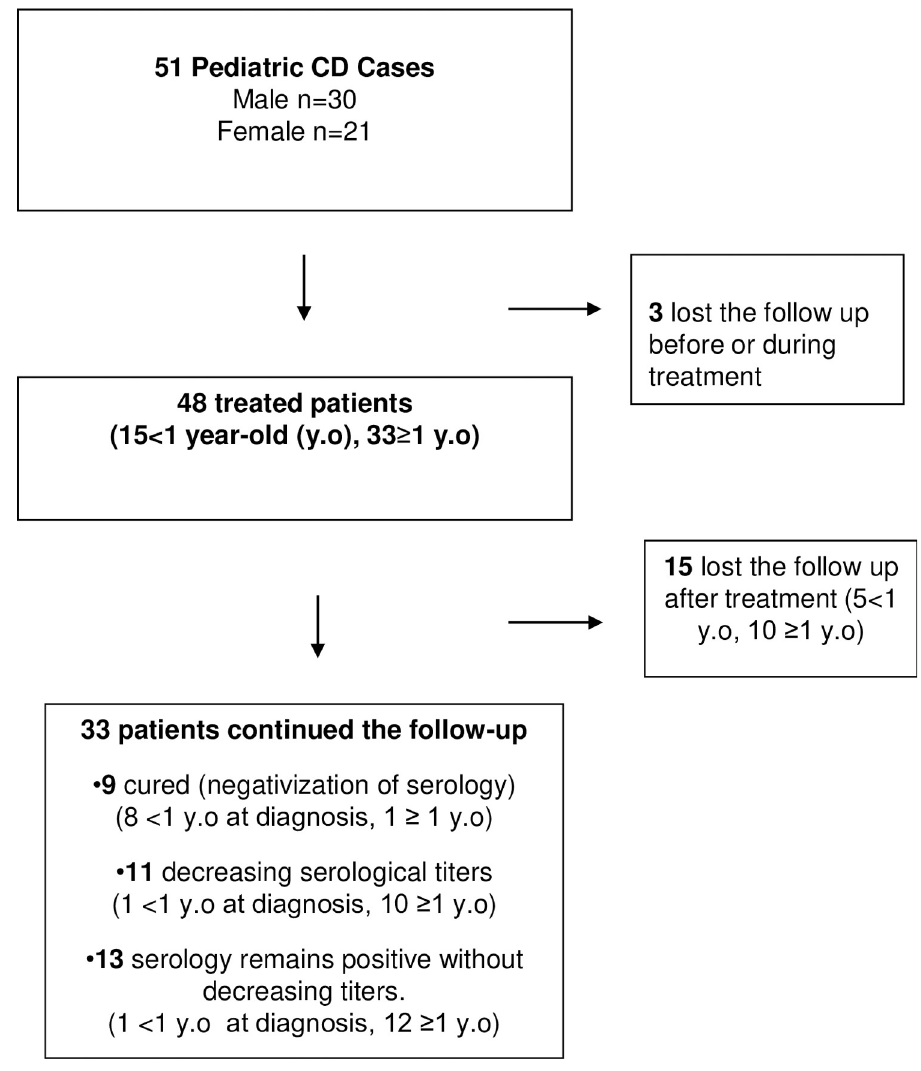
Fig 1. Patient flow chart of the